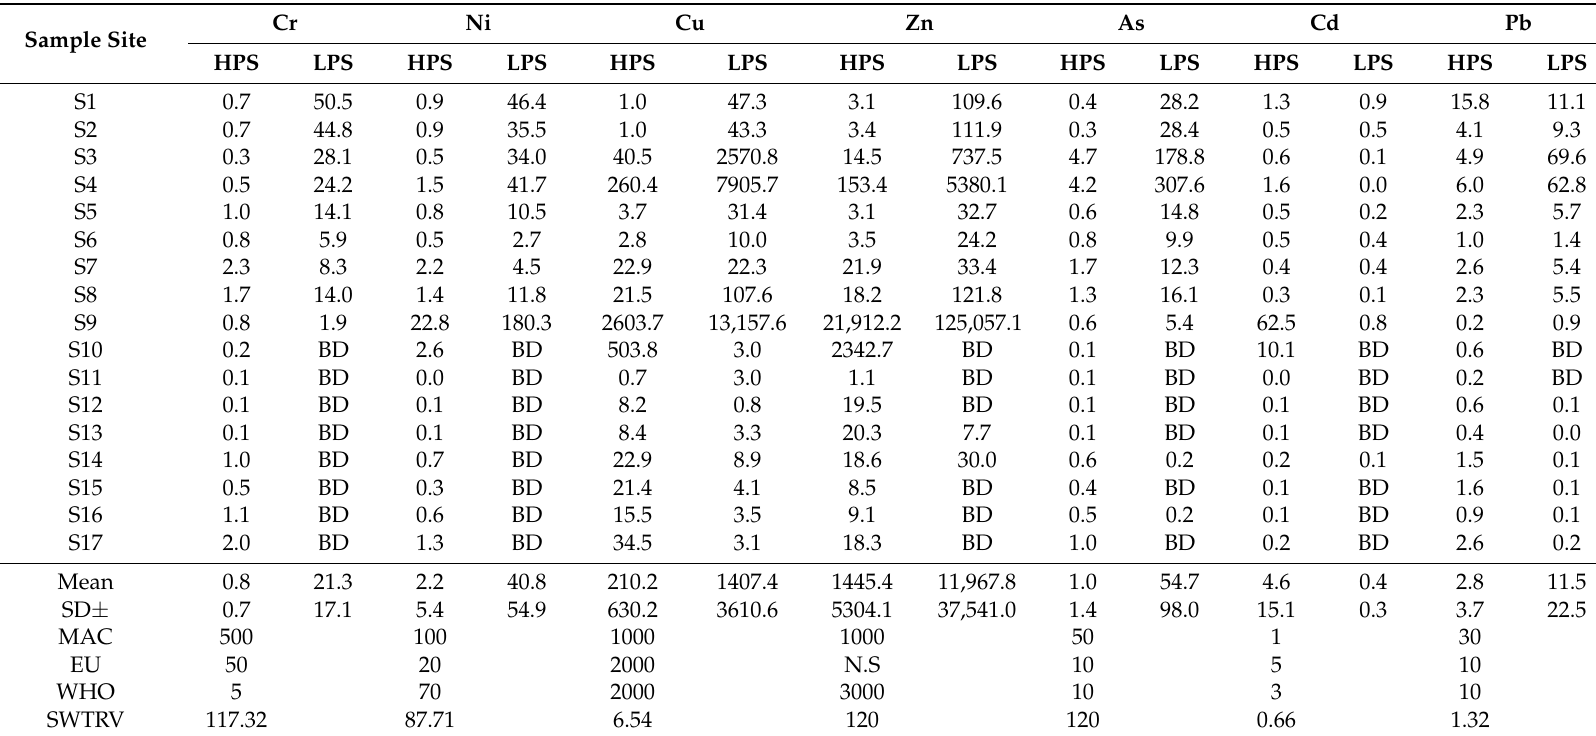
Table 8. Average heavy metal concentrations in water samples ( µ g/L) for the HPS and LPS as well as various heavy metal concentration